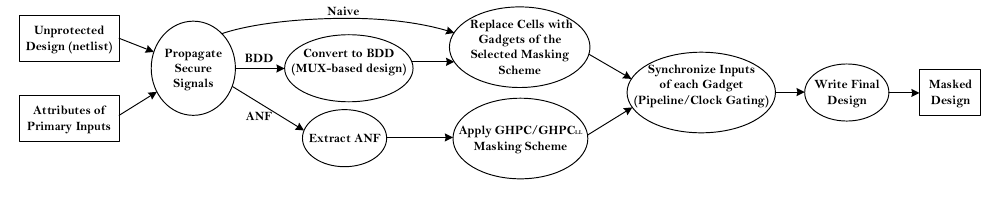
Figure 8: General procedure of AGEMA to generate a masked